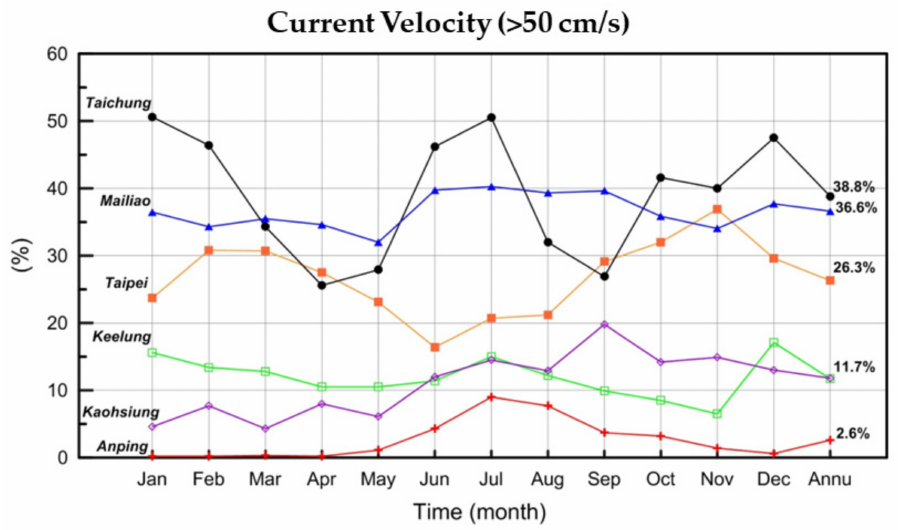
Figure 13. The current velocity of six major ports of